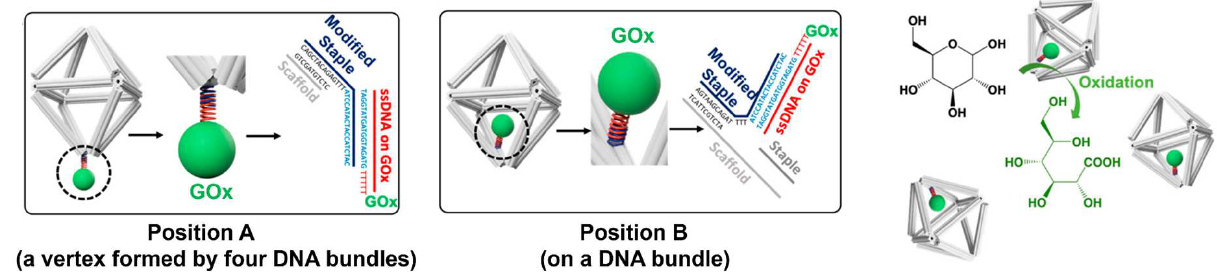
Figure 6. Glucose oxidase (GOx) was anchored on the different positions of the octahedral DNA scaffold to study the local pH environment of scaffold [77]. Reprinted with permission from Ref. [77]. Copyright 2020 American Chemical Society.